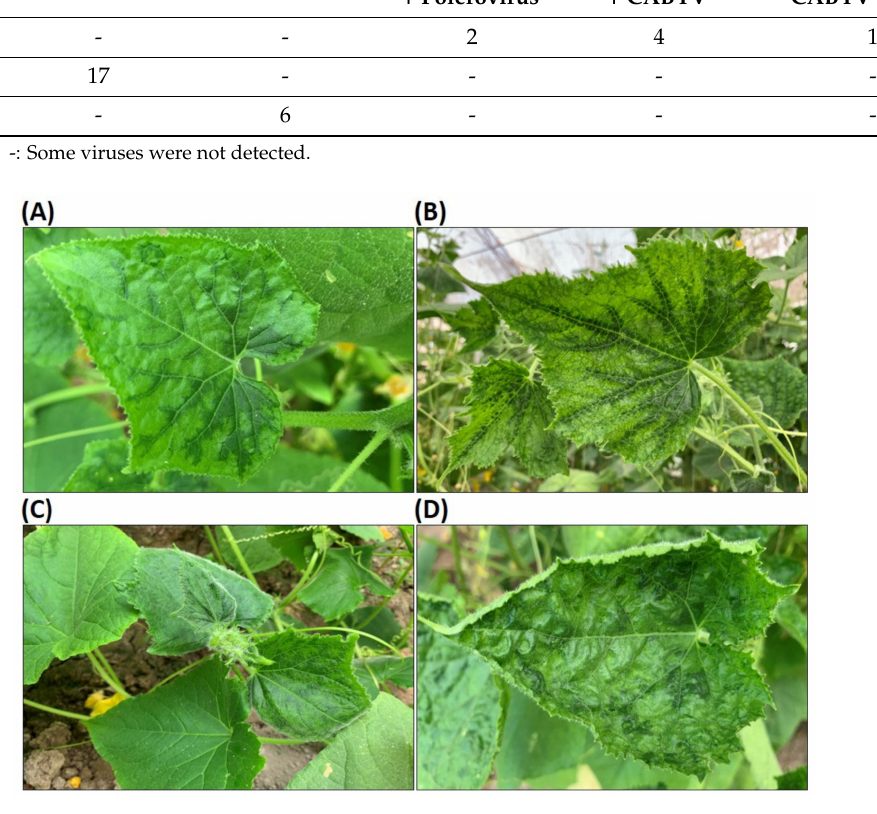
Figure 1. Symptoms caused by viral diseases on cucumber samples. ( A , B ) are the plants infected with CMV, ZYMV and CABYV, ( C ) is a plant infected with CMV, ZYMV and an unidentified Polerovirus and ( D ) is the plant infected with CMV, ZYMV, CABYV and